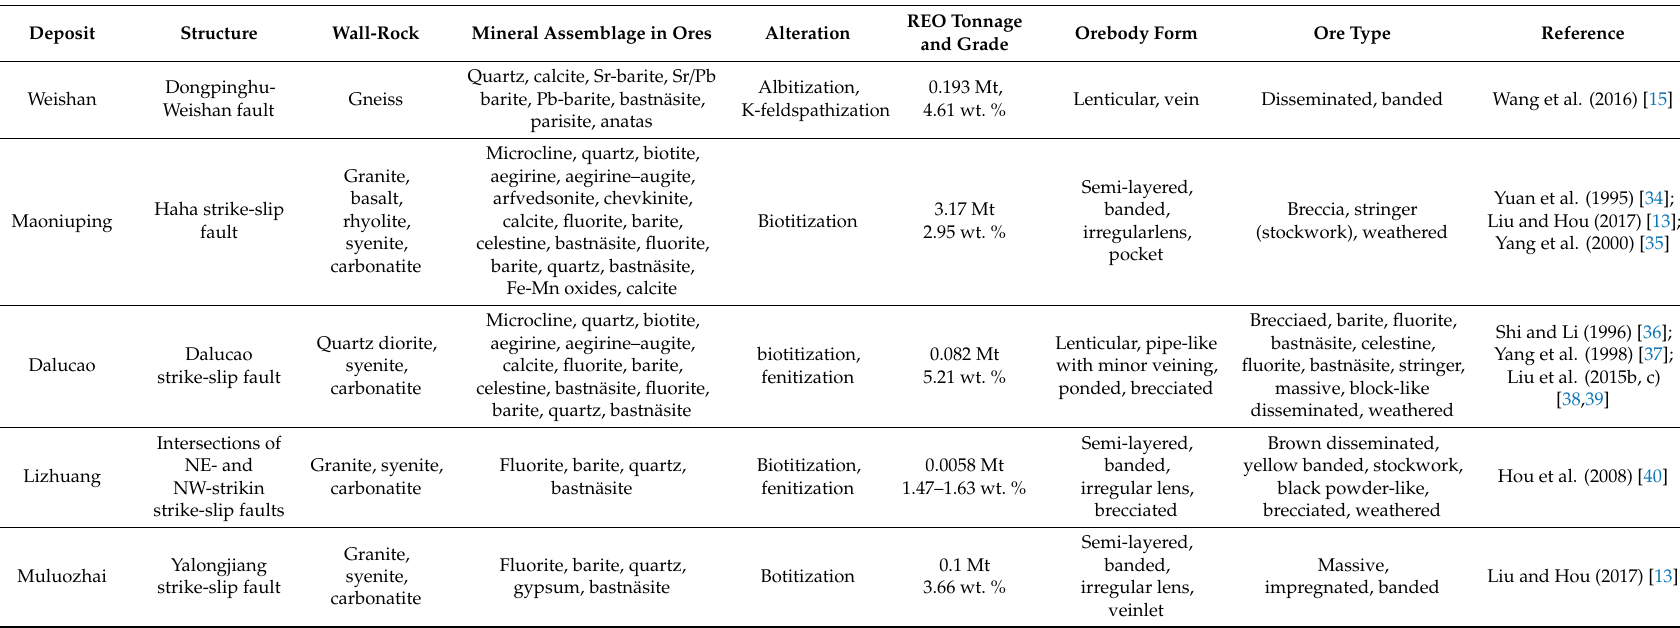
Table 1. Summary of the geological characteristics of the Weishan and Mianning–Dechang REE